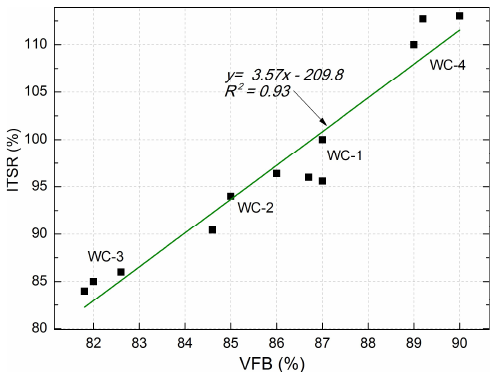
Figure 5. Correlation between voids in the mineral mixture filled with VFB binder and indirect tensile strength ratio (ITSR).